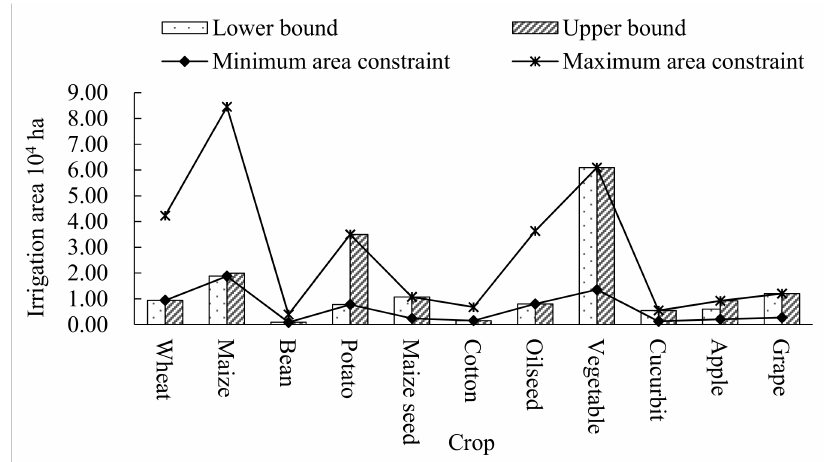
Figure 7. Optimal allocation area distribution for 11 crops ( λ i = 30%, P i = 0.1) and the maximum and minimum crop area constraints.